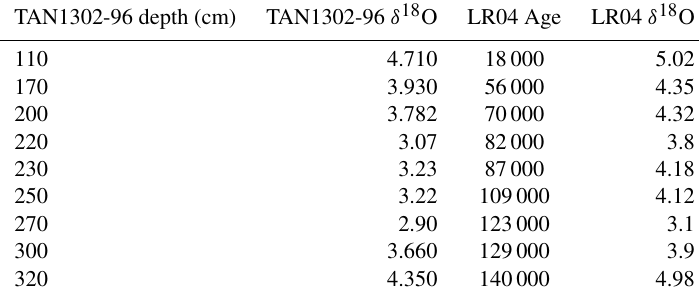
Table A2. Tie points used in construction of the TAN1302-96 age